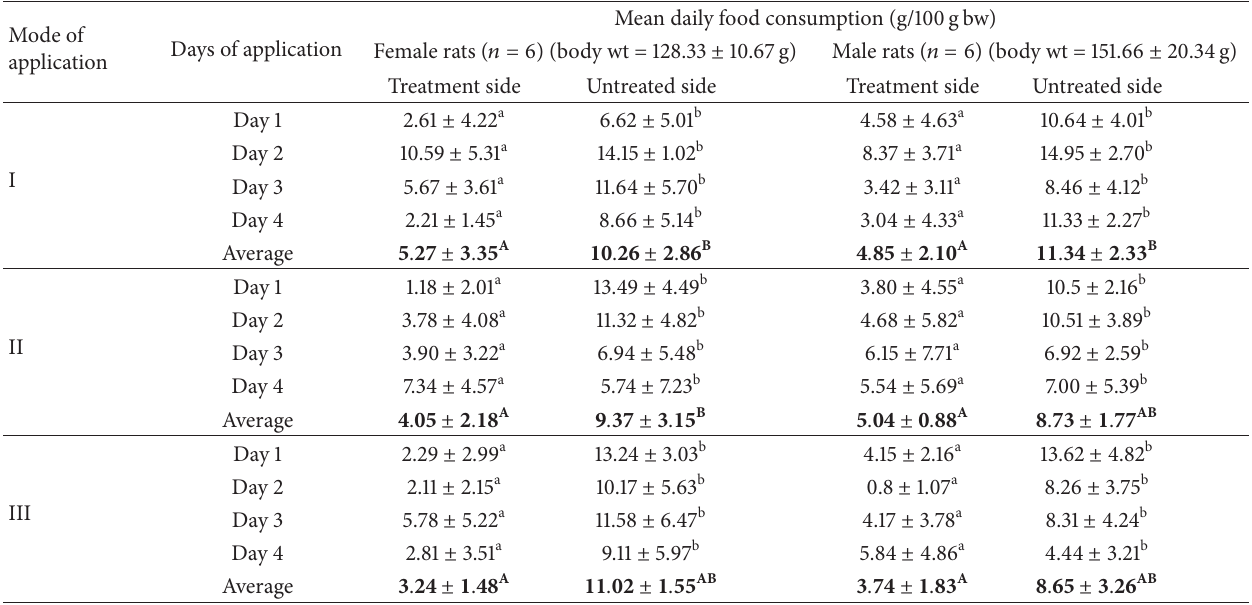
Values are mean ± SD, I = daily, II = once a week, and III = alternatively. Values with similar superscripts in a column for four days of application (a or b) and for average values (A or B) at each mode of application indicate no significant difference. Values with different superscripts in a row for each sex for four days of application (a-b) and for average values (A-B) at each mode of application indicate significant difference at 𝑃 ≤ 0.05 .